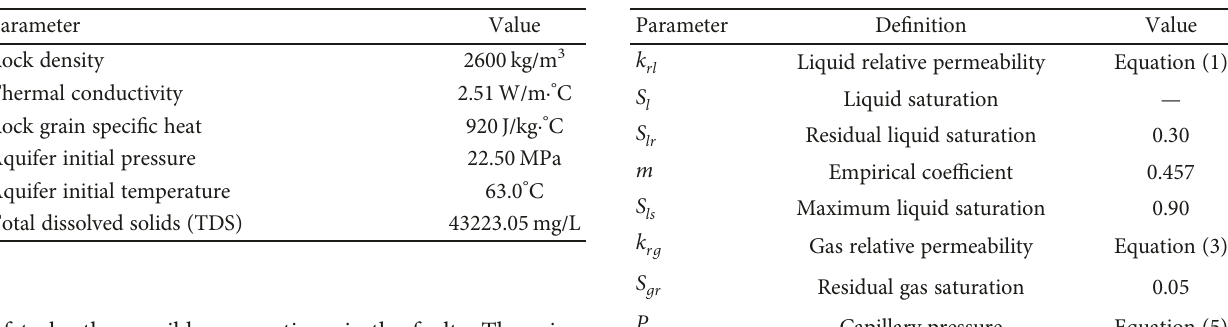
Figure 7: Rock samples from the Donggou Formation for parameter testing. Table 1: Parameters of rock used in the model. Table 2: De fi nitions for